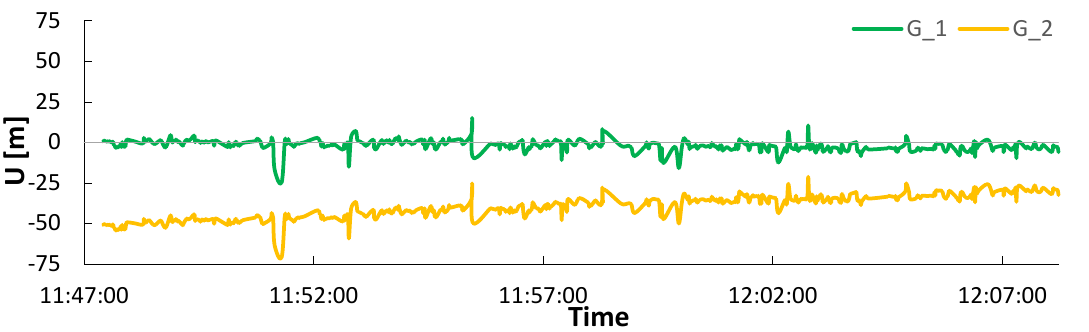
Figure 12. Plot of NE component deviations of surface measurements with code receivers.